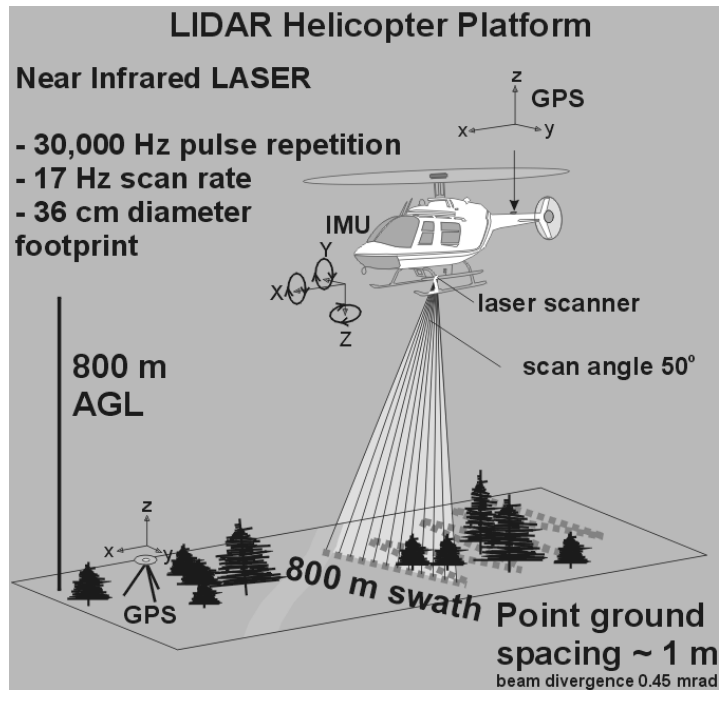
Figure 2. LiDAR configuration for the April 2004